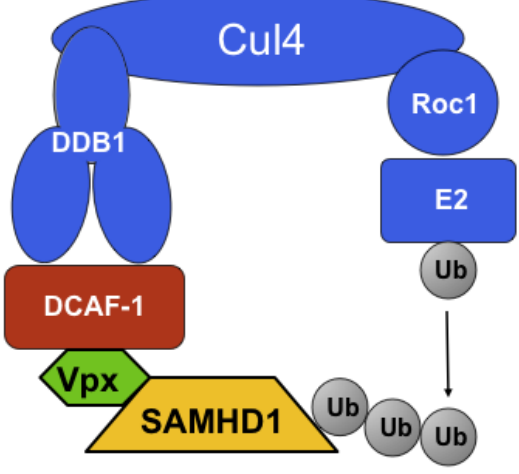
Figure 2. Proposed model for the ubiquitin ligase complex responsible for putative ubiquitination of SAMHD1. Adapted from